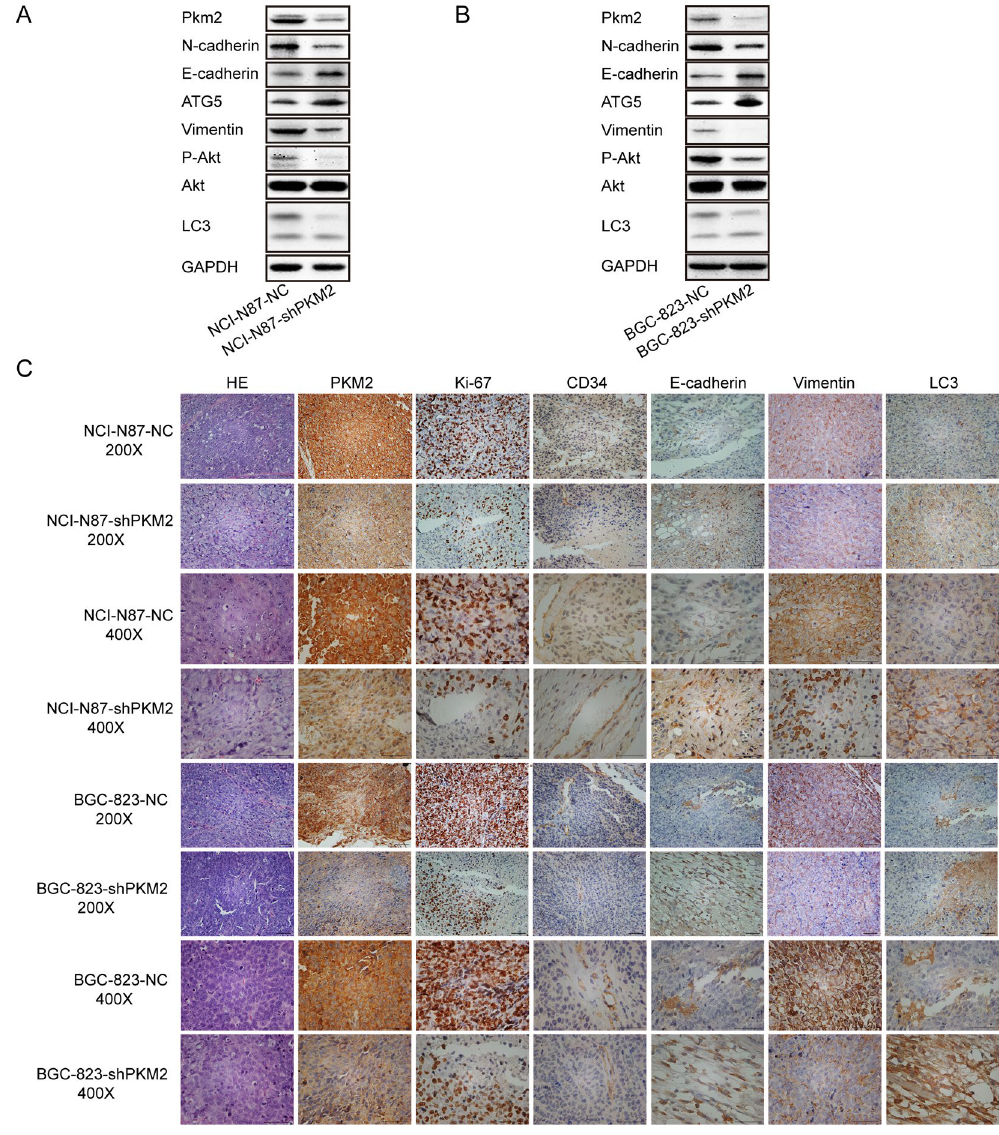
Figure 5. The effect of PKM2 knockdown on NCI-N87 cells and BGC-823 cells in a xenograft nude mice model. ( A and B ) Expression of N-cadherin, E-cadherin, ATG5, Vimentin, P-Akt, Akt and LC3 were mediated by PKM2 knockdown in the xenografts of nude mice. Full-length gels and blots are presented in the Supplementary files 2. ( C ) Representative photomicrographs from tumor serial sections stained with PKM2, Ki- 67, E-cadherin, Vimentin, CD34 and LC3 by IHC. Scale bar, 200 × , 100 μ m, 400 × , 50 μ